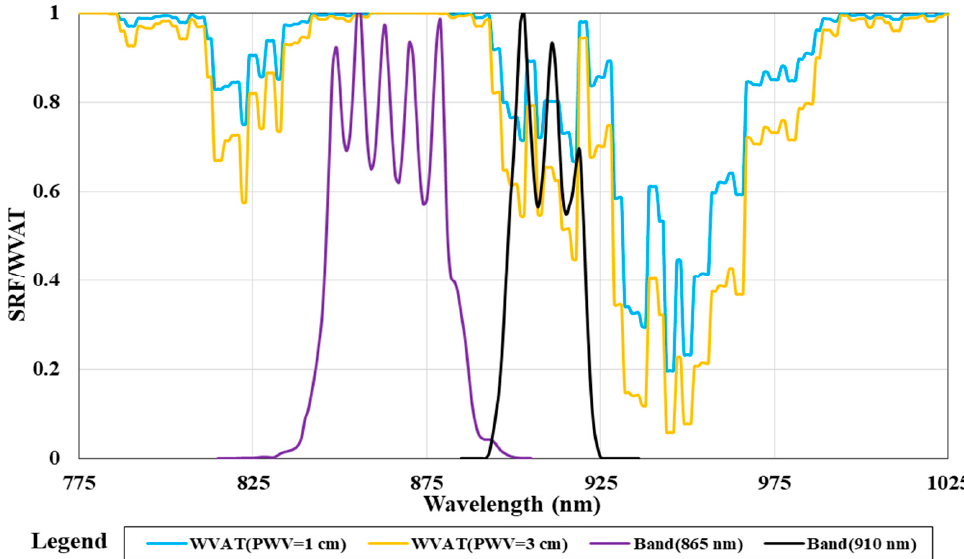
Figure 1. The SRFs of two near-infrared bands of DPC are illustrated by a purple line (denotes 865 nm) and a black line (denotes 910 nm), respectively. The blue line and yellow line represent the WVAT when PWV is equal to 1 and 3 cm, respectively